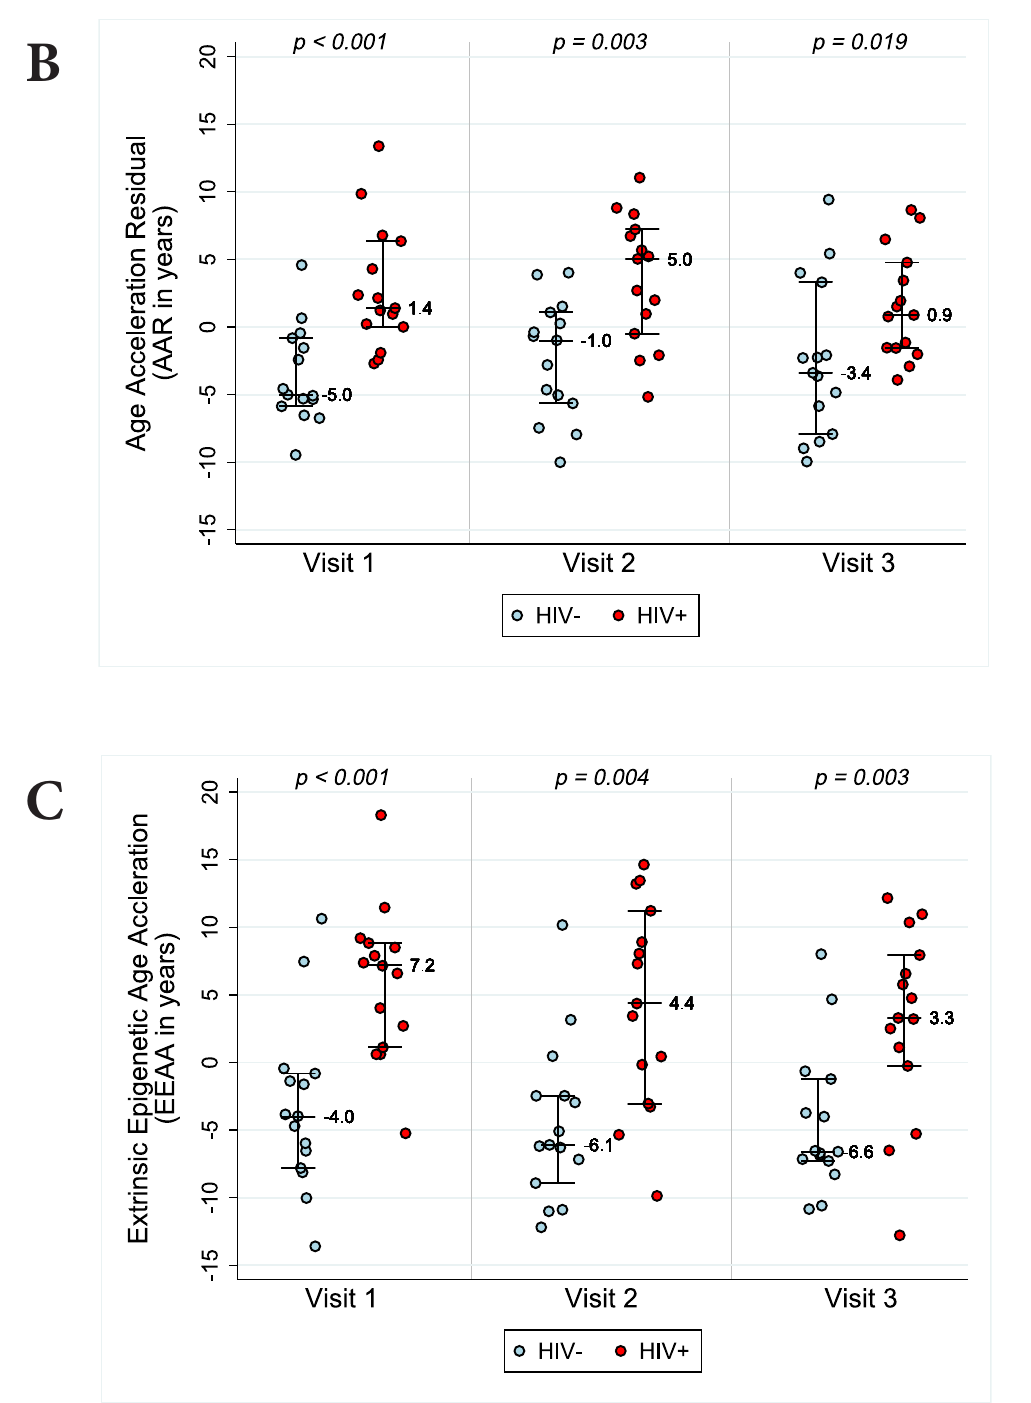
Figure 1B & C. Epigenetic age acceleration for HIV- and HIV+ before and after initiation of ART. Box plots of Methylation Age minus Chronological Age (Figure A), age acceleration residual (Figure B), and Extrinsic age acceleration (Figure C), in years of two groups, HIV- and HIV+ individuals (n=15 per group). Reported p values are a result of Wilcoxon rank sum tests between the two serostatus groups at the 3